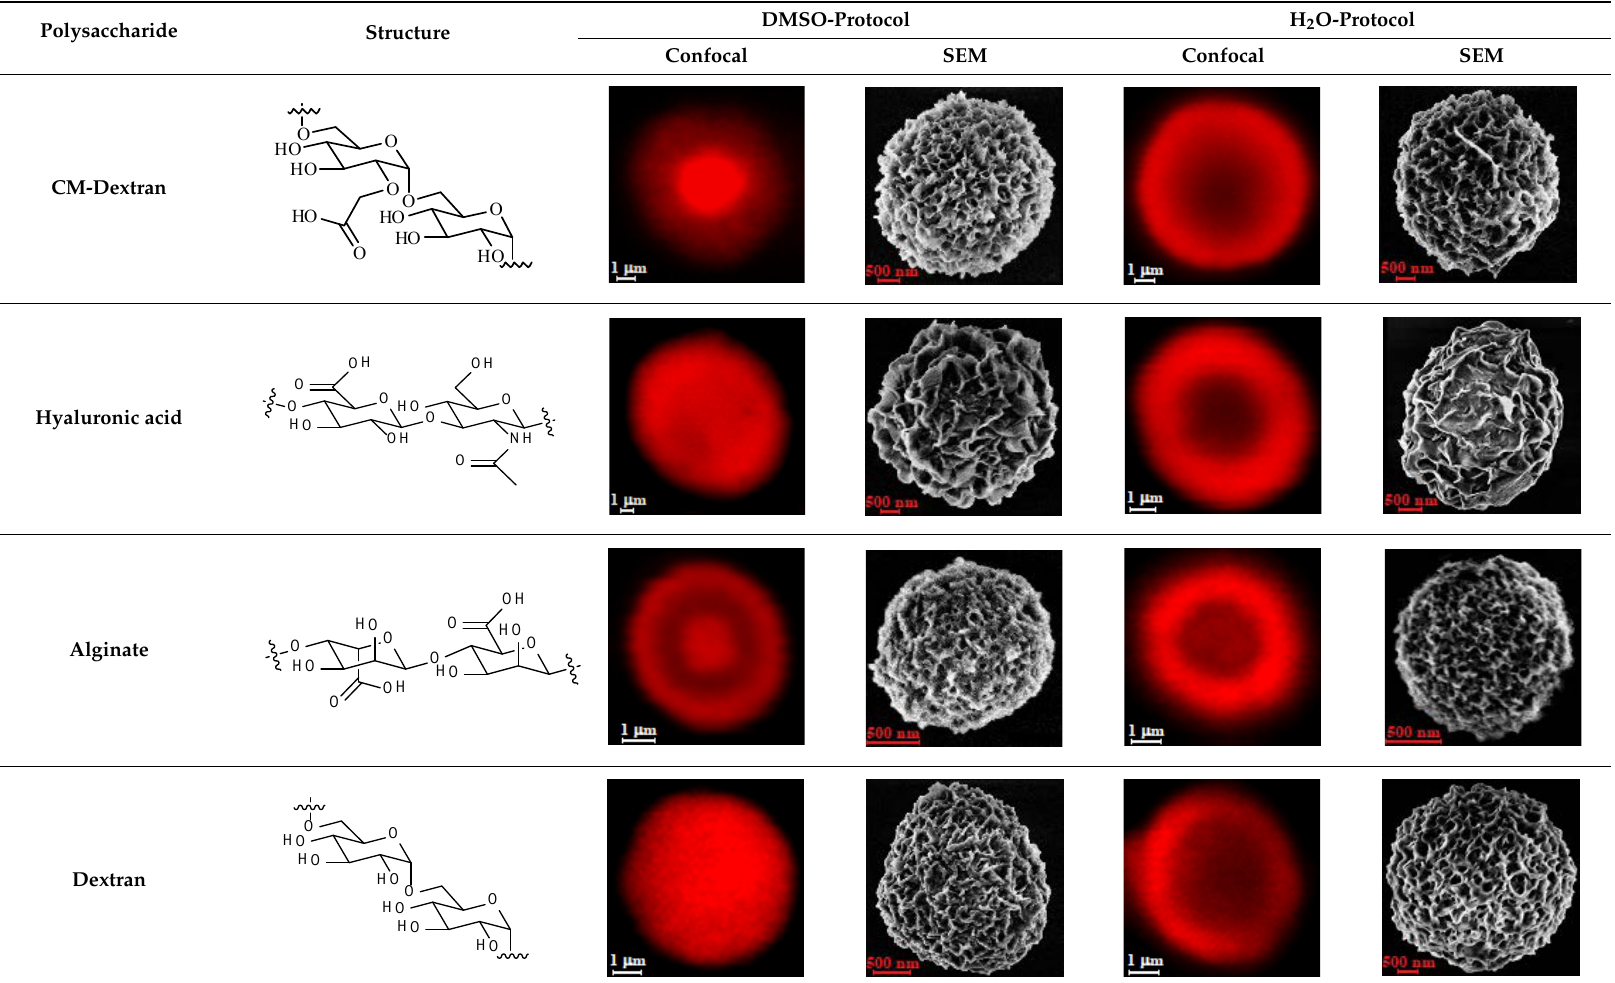
Table 1. Nanoporous microsponge particle (NMP) microstructures for di ff erent polysaccharides and for the two protocols (DMSO vs. H2O solvent of cross-linker).